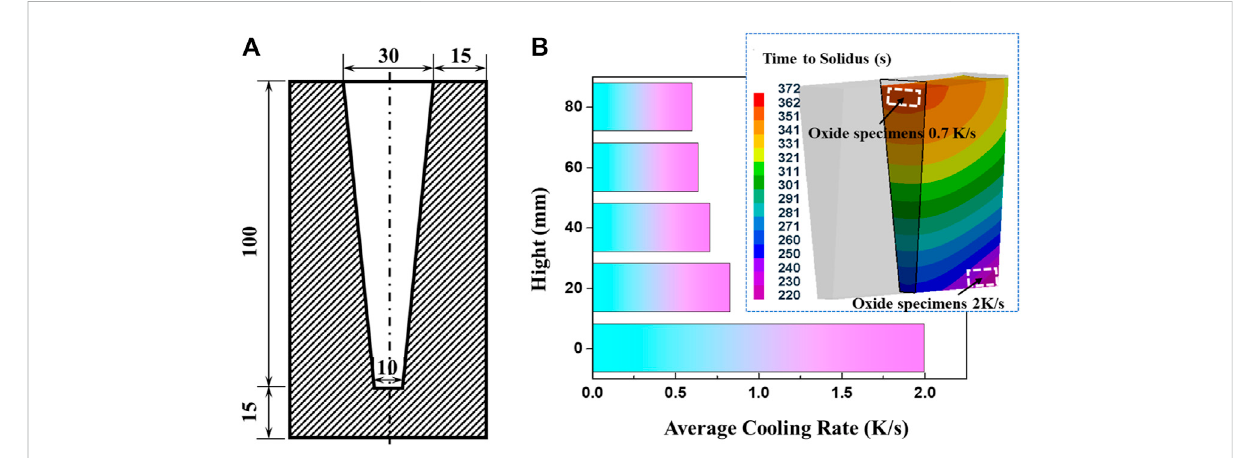
FIGURE 1 The structure of resin sand mold (A) and the cooling rates at different sections (B) .